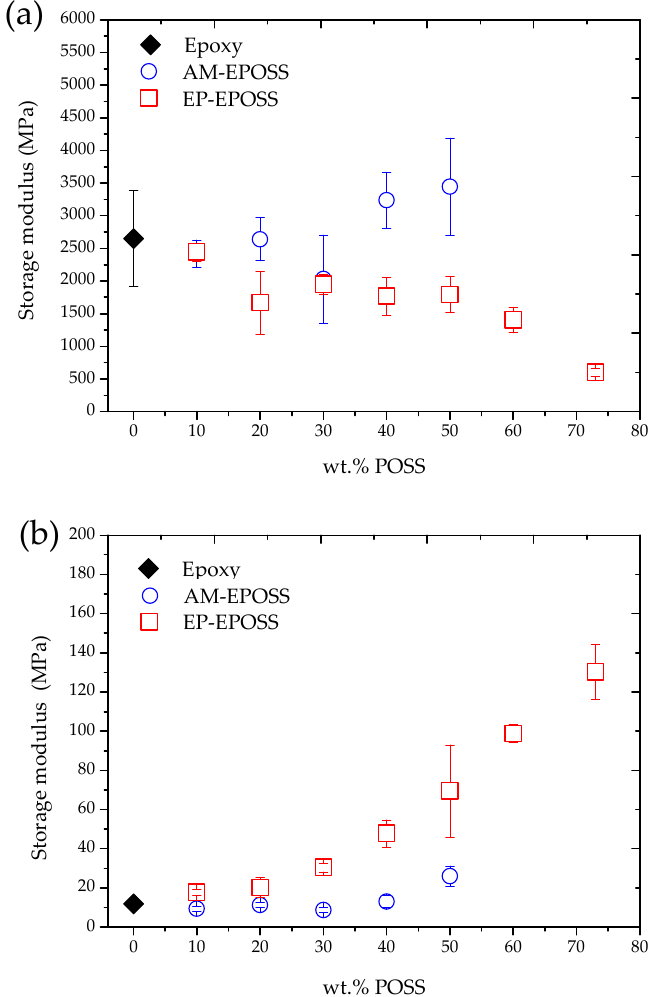
Figure 5. The effect of POSS type and content on the storage modulus of EP–EPOSS and AM–EPOSS shape memory polymers (SMPs) at ( a ) 30 °C and ( b ) 120 °C.